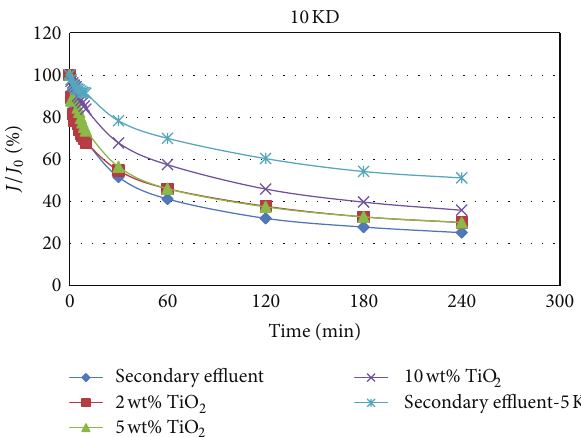
Figure 3: Effects of different UV irradiation types on permeate flux (5KD, 10% TiO 2 ).